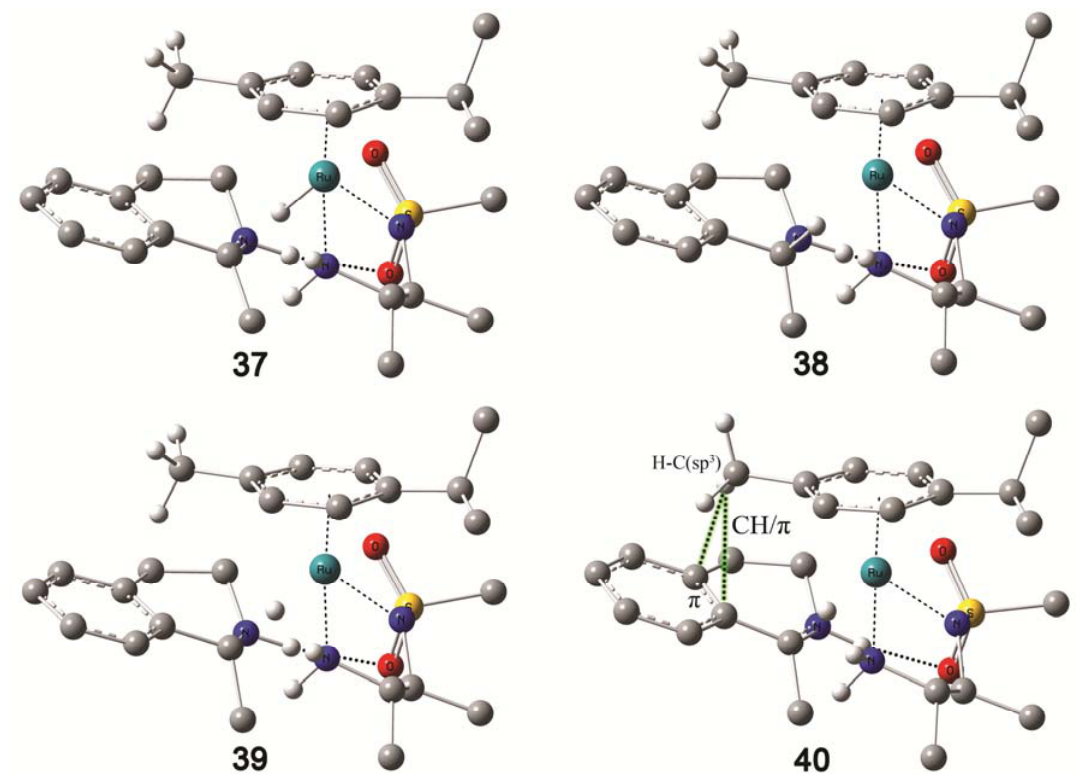
Figure 8. Cut-off input geometries for TS optimization. The C(sp 3 )H/ π interaction is shown in green. The unnecessary hydrogen atoms have been omitted for